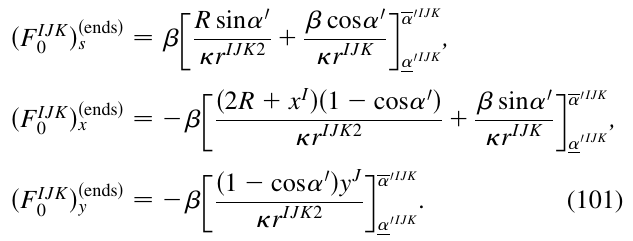
- y vertically. Fields are t s